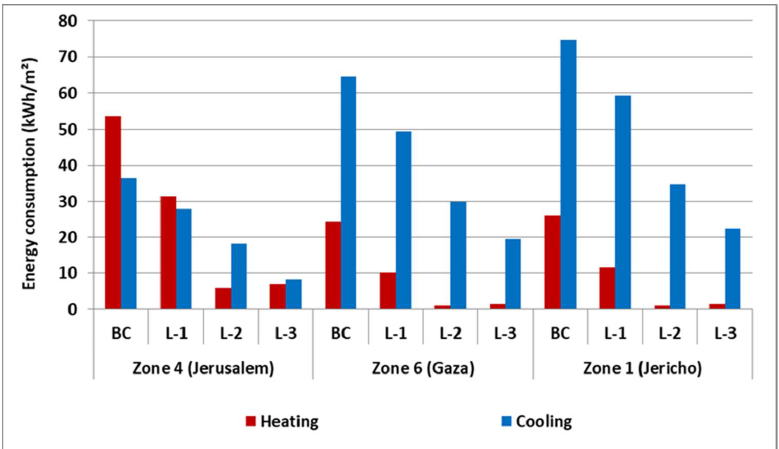
Figure 6. Saving in energy for heating and cooling from applying the retrofit plan on buildings with four residential units per floor area in different climatic zones in Palestine.